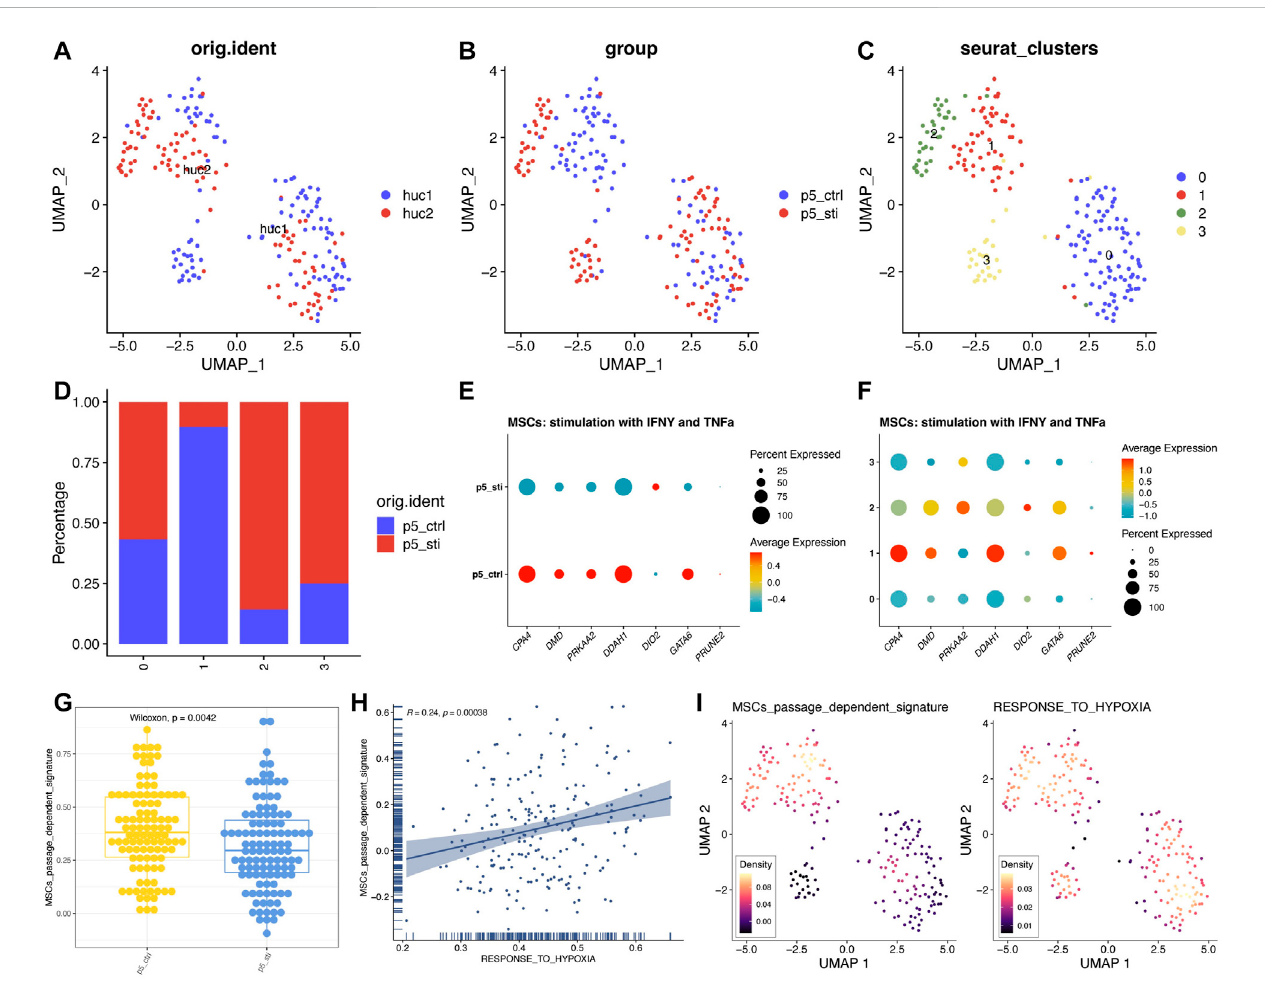
FIGURE 8 High expression trend of seven genes of MSCs treated with IFN γ and TNF α . (A) UMAP plot of MSCs from different sources. (B) UMAP plot of MSCs from different groups. (C) UMAP plot of MSCs from different clusters. (D) Detailed proportion of MSCs in different clusters and groups. (E) Expression pattern of seven genes in different groups. (F) Expression pattern of seven genes in different clusters. (G) Signature score of seven genes in different groups. (H) Correlation analysis between different signatures. (I) UMAP plot of different